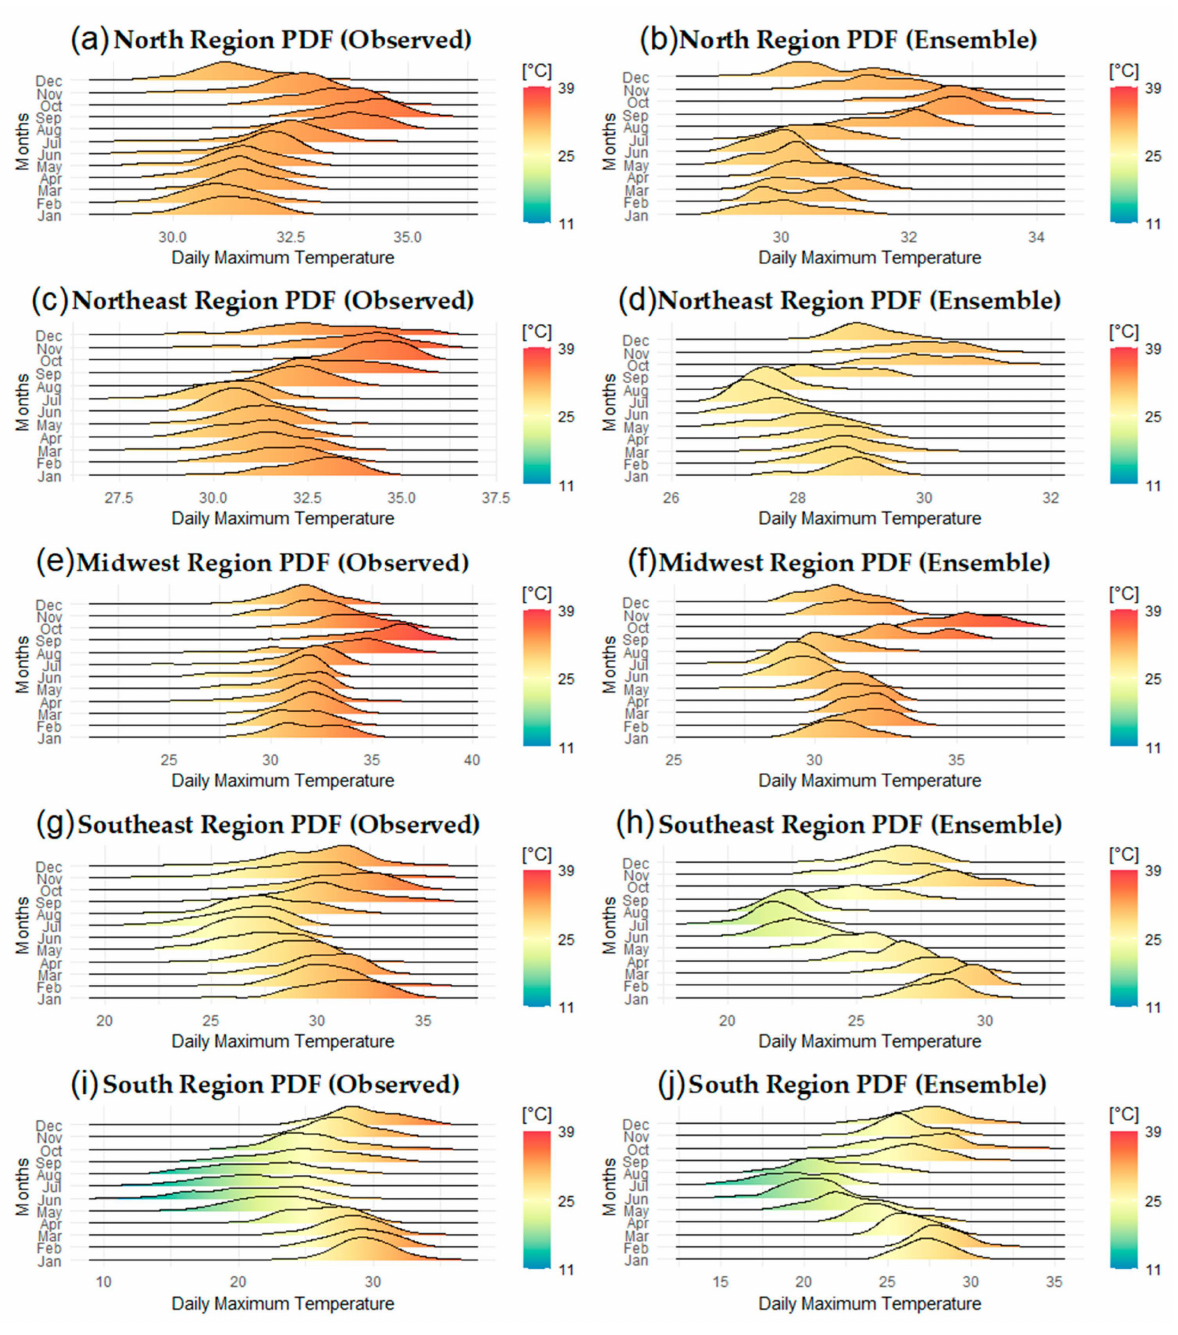
Figure 11. Maximum temperature probability density ( ◦ C), with observed data on the left and BAM data on the right, for each Brazilian region: NO ( a , b ), NE ( c , d ), CO ( e , f ), SE ( g , h ), and S ( i , j